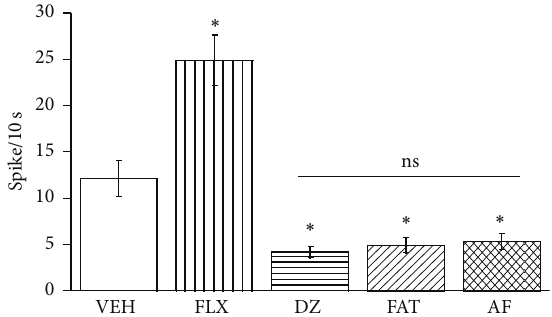
Figure 2: Overall effects of treatments. The lateral septal nucleus spontaneous neuronal firing rate is shown in the groups treated with vehicle (VEH), fluoxetine (Flx), diazepam (DZP), the fatty acid mixture (FAT), and fresh amniotic fluid (AF). The diazepam, fatty acid mixture, and fresh human amniotic fluid groups had the lowest values, and the fluoxetine group had the highest value compared with vehicle ( 𝑃 < 0.05 ,